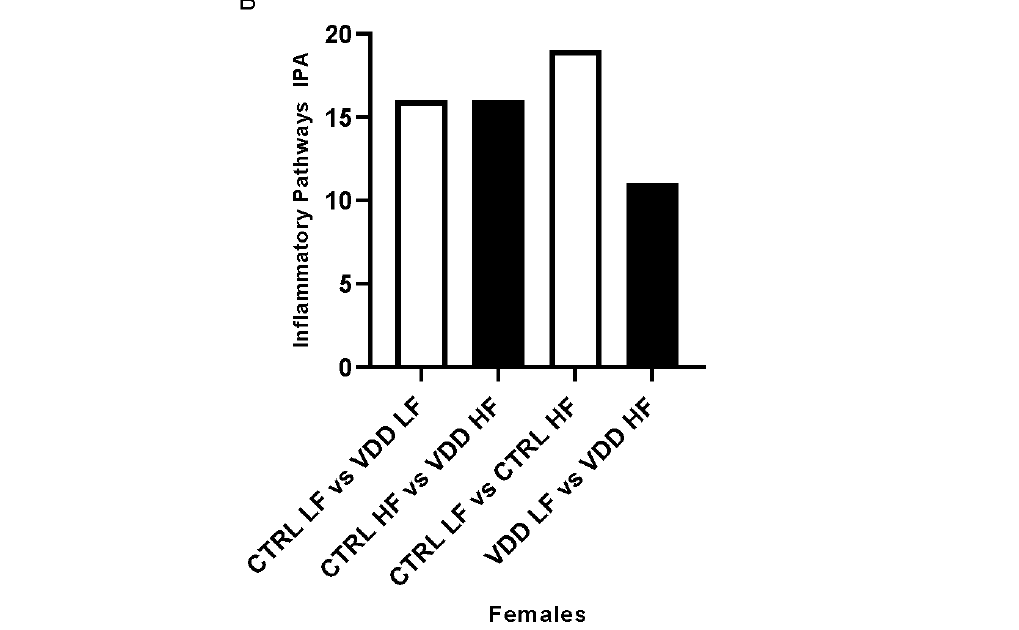
Figure 3. Inflammatory pathway linked to miRNA profile in adipose tissue of the offspring. Quantita- tive representation of miRNA expression in inflammatory pathways resulting in differential miRNA expression in retroperitoneal adipose tissue of the male offspring ( A ) and female offspring ( B ), using Ingenuity Pathway Analysis (IPA). Two sets of data were employed. The first is CTRL LF vs. VDD LF and CTRL HF vs. VDD HF. The second data set is CTRL LF vs. CTRL HF and VDD LF vs. VDD HF. Bars in white correspond to up-regulated pathways and bars in black for down-regulated pathways. TargetScan (genes were selected with an Aggregate PC 90%) and mirDB (genes were selected with a target score 80%) were used to identify inflammatory miRNA and create a predicted mRNA target list. The miRNA inflammation-related pathways in white adipose tissue were analysed using IPA. To assess the influence of the maternal diet and/or the adult diet on inflammation pathways in the offspring, quantitative analyses were carried out.